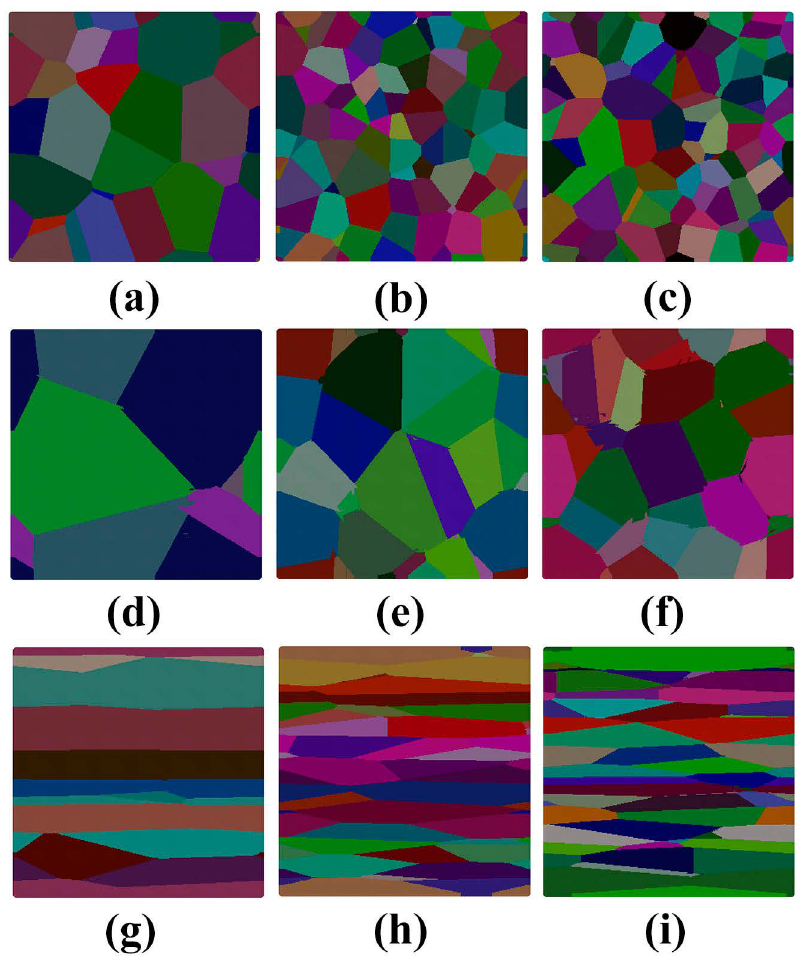
sections with grains that grow with aspect ratios (a) 1 = 0.5; (c) 1:1:1 on plane x 1